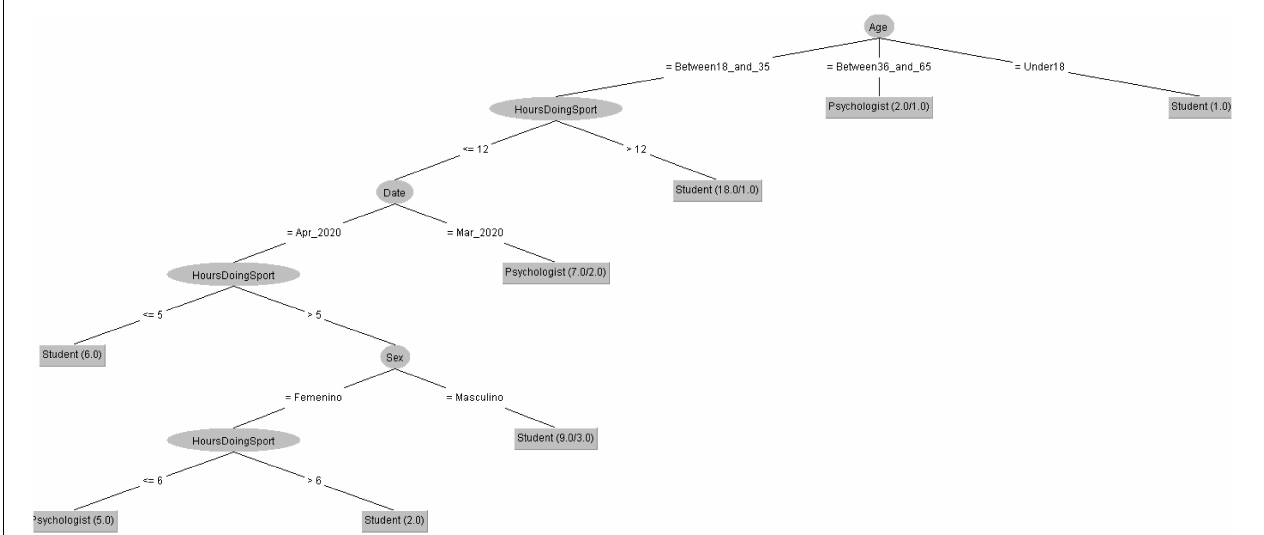
FIGURE 10 | Profession of people taking the POMS questionnaire in 2020 decision tree.